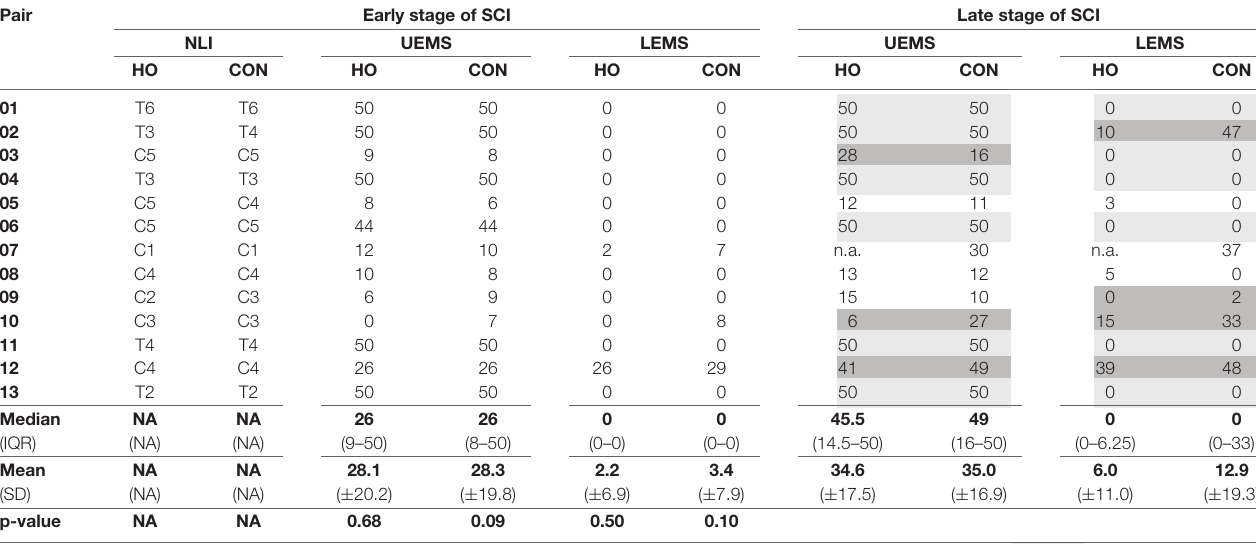
In the late stage, cells shaded in dark gray denote worse outcome for the individual with proved HO compared to the matched control, cells in light gray highlight equal results for both matching partners, and white cells indicate a worse outcome for the participant who serves as matched control. Abbreviations: CON, controls; HO, heterotopic ossification; IQR, interquartile range; LEMS, lower extremity motor score; NA, not applicable; n.a., not available; NLI, neurological level of injury; SCI, spinal cord injury; SD, standard deviation; UEMS, upper extremity motor